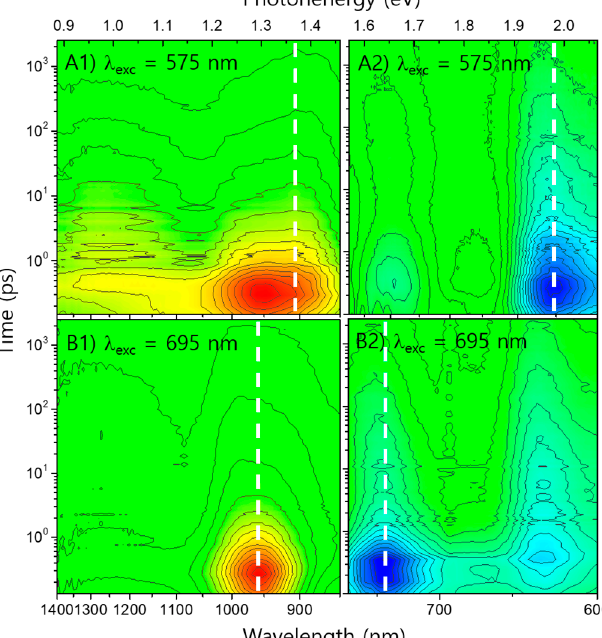
Figure 5. TA spectra of P : I blend films excited at 575 nm for the ( A1 ) IR and ( A2 ) visible range in addition to those excited at 695 nm for the ( B1 ) IR and ( B2 ) visible range. The Δ OD intensities are mapped with linear-scale contour lines combined with color assignment from positive values (red) to zero (green) to negative values (blue). The white dashed lines mark the main bands of pristine film samples.